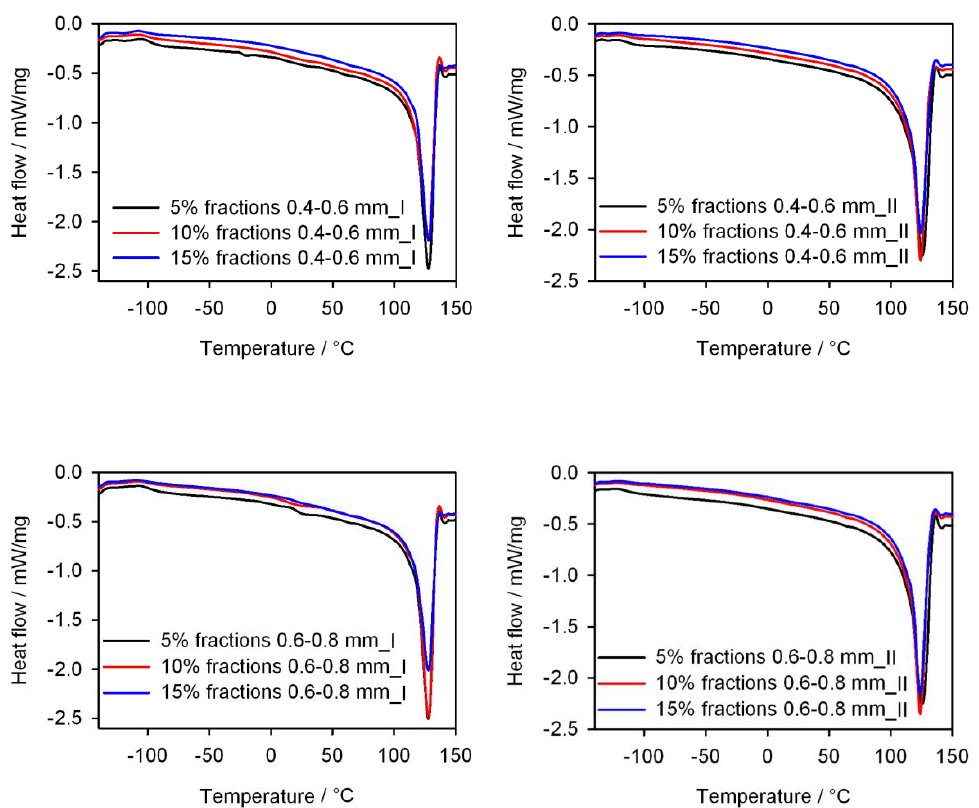
Figure 18. DSC curves from the first and second heating cycle of components and composites with different bran content.